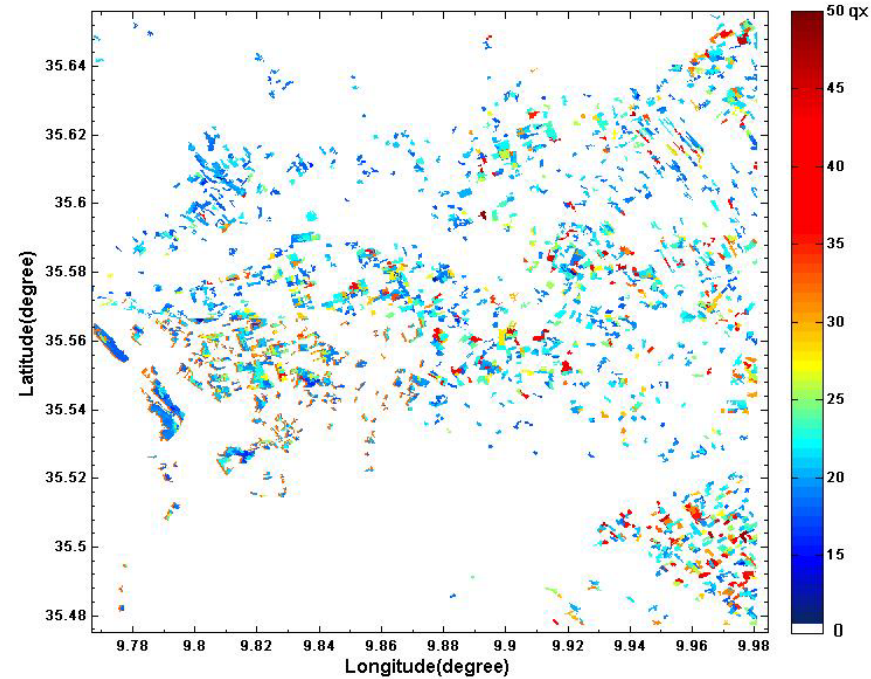
Figure 13. Cereal yield map produced by combining SPOT/HRV multi-temporal acquisitions with SAFY-modeled yields computed with the LAI corresponding to the period of maximum growth.